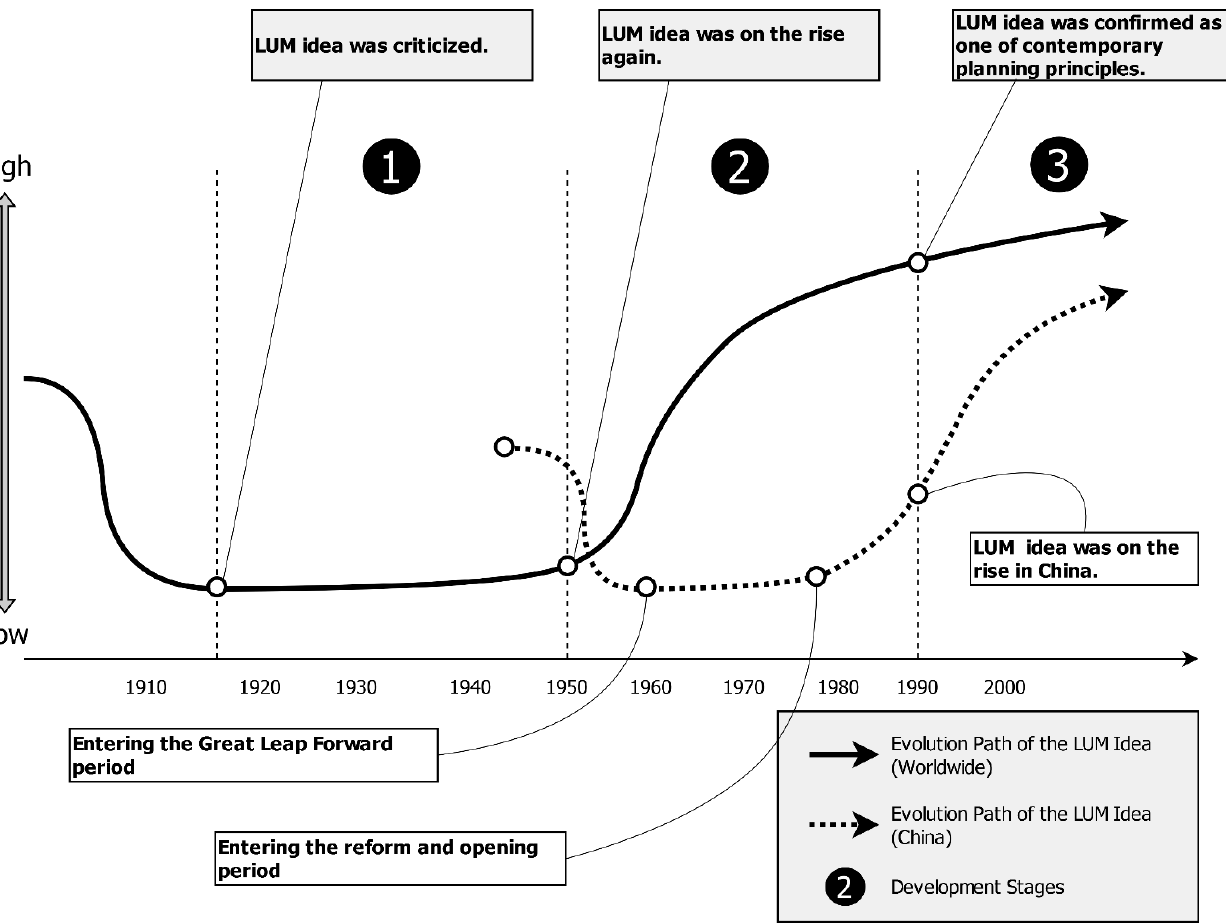
Figure 2. Historical development of the LUM idea (adapted from: [9]).